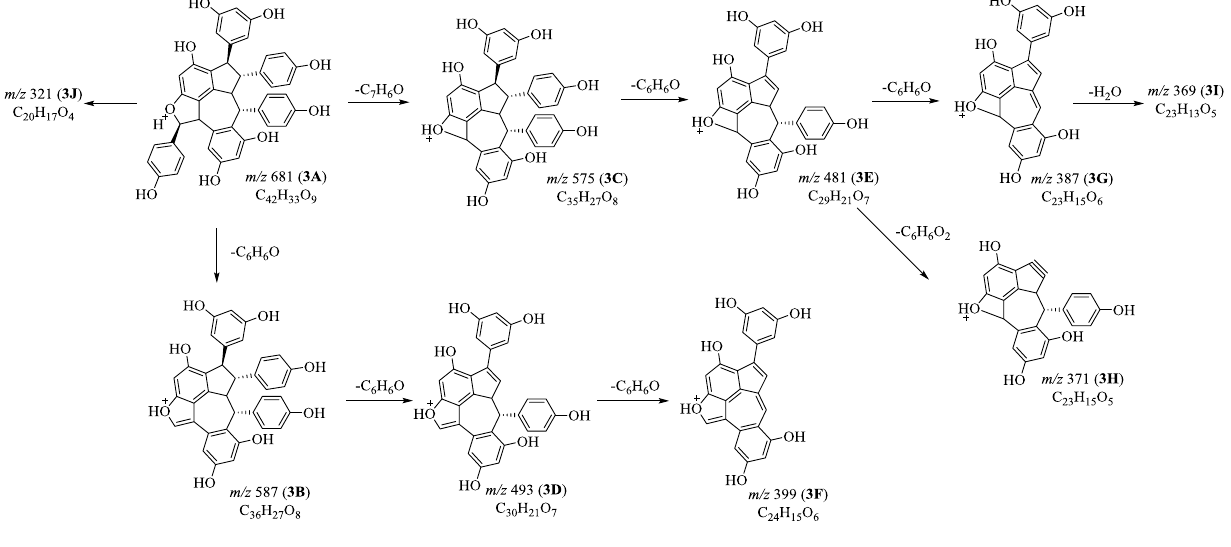
Fig. 6 Proposed fragmentation pathways of suffruticosol A ( 3 ) in positive